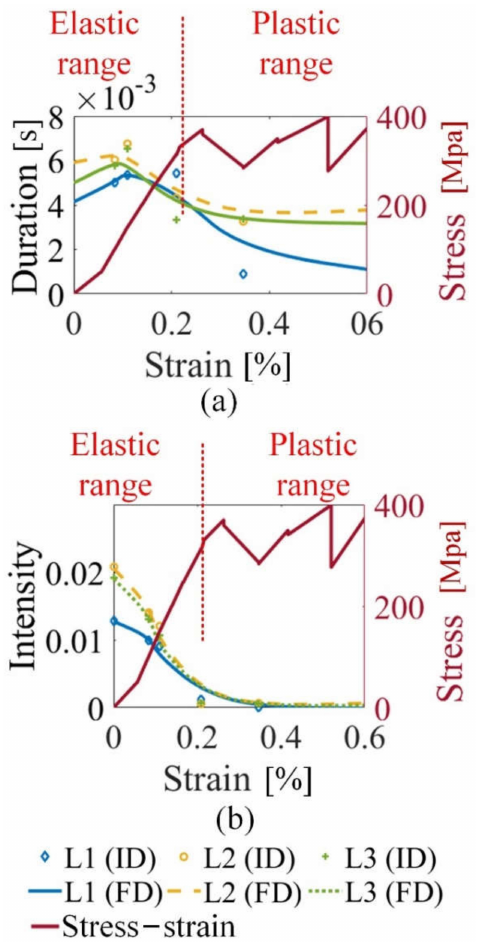
Figure 10. The MBN transient eigenvalues ( T σ and INT σ ) on different locations under stress of sample 2. ( a ) illustrates the duration on different locations of sample 2; ( b ) illustrates the intensity of on different locations of sample 2. FD denotes the fitting data, and ID denotes the original